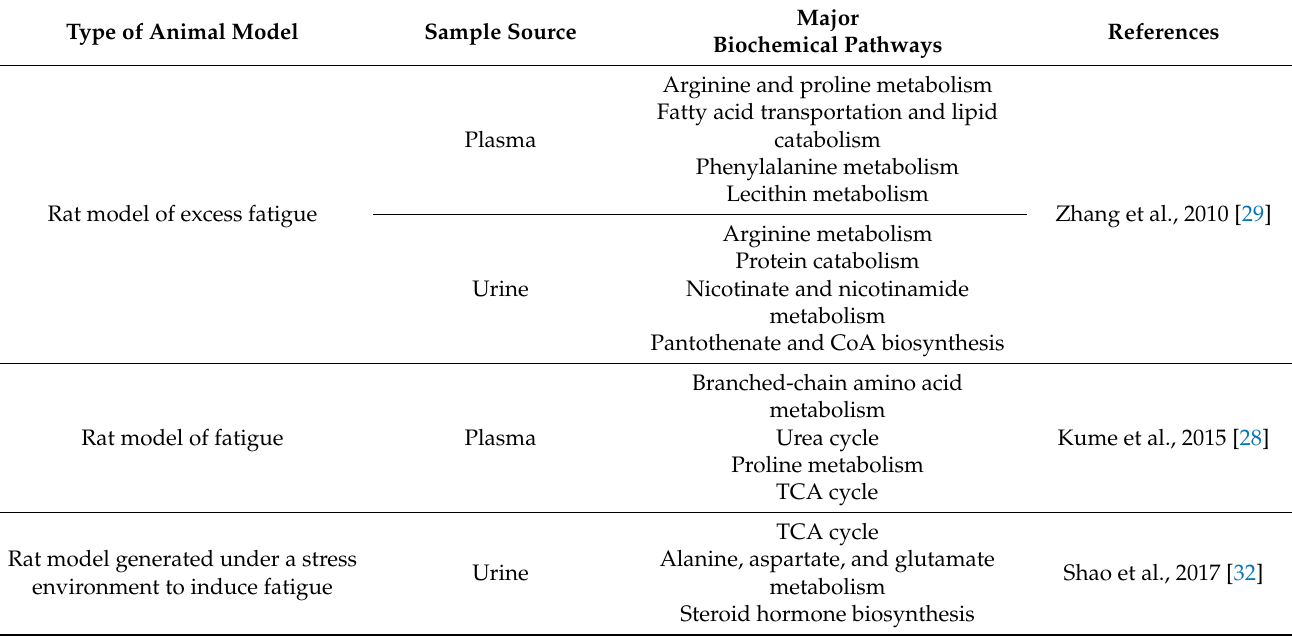
Table 1. Summary of major biochemical pathways with significant metabolites across fatigued animal